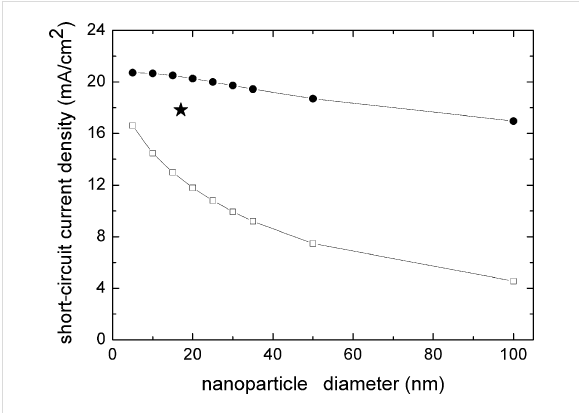
Figure 6: Short-circuit current density calculated for the model elec- trode, for varying titania nanoparticle size (i.e., varying the dye loading); dark circles: neglecting LT phenomena; open squares: considering the maximum LT. The star represents the value of the current density calculated for the case of experimentally determined light trapping using the average diameter of the TiO 2 nanoparticles.